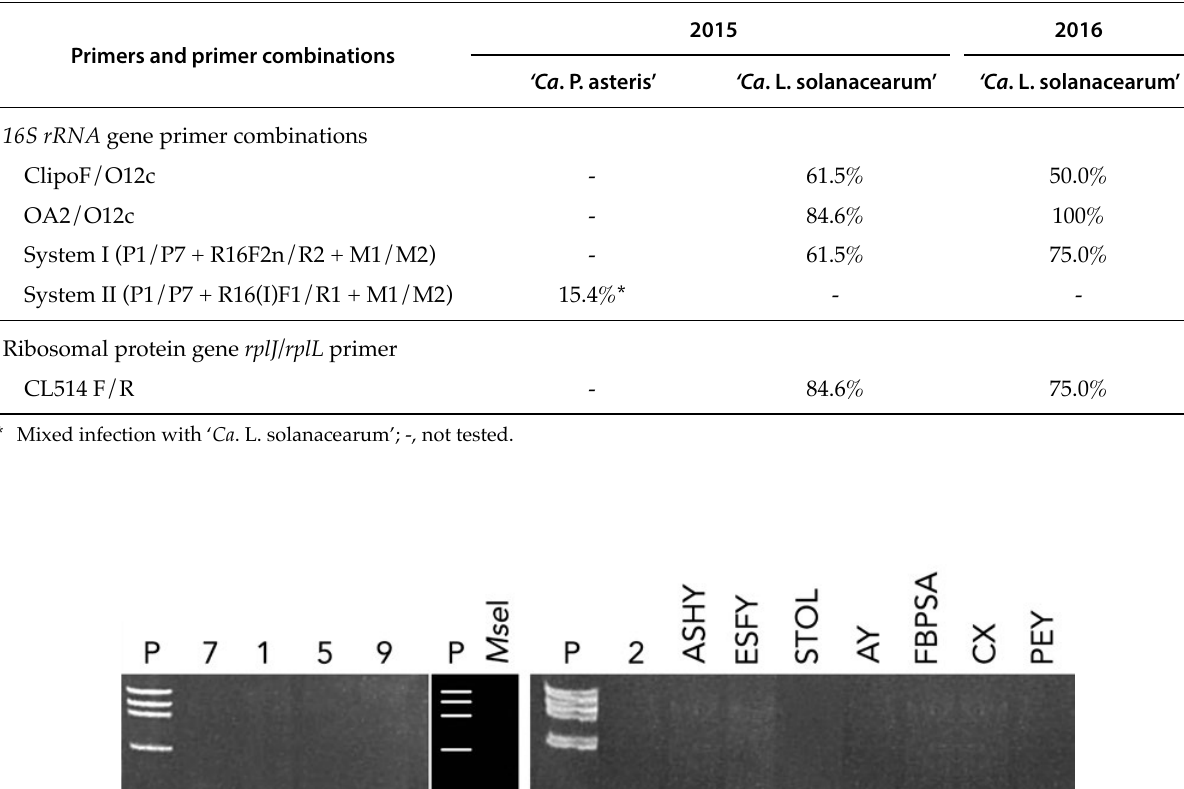
Table 2. Results of ‘Ca . L. solanacearum’ and ‘ Ca . P. asteris’ detection in carrot with the different primer combinations. ‘Ca . L. solanacearum’ was detected with the primers ClipoF/O12c, OA2/O12c and CL514 F/R but also with the system I (P1/